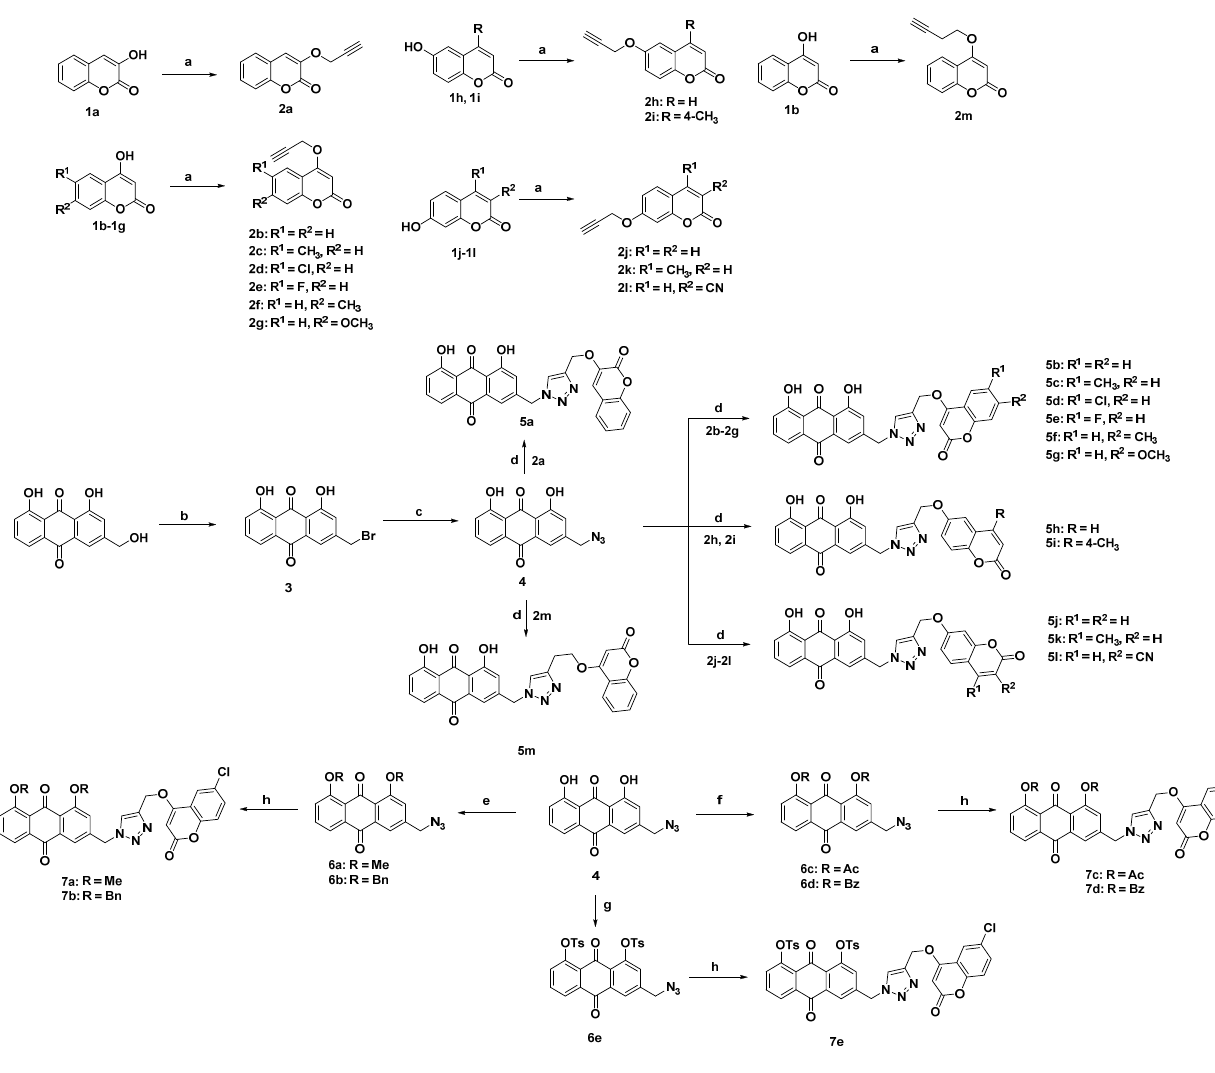
Table 1. The structures, yields and melting points of target compounds 5a – m and 7a –